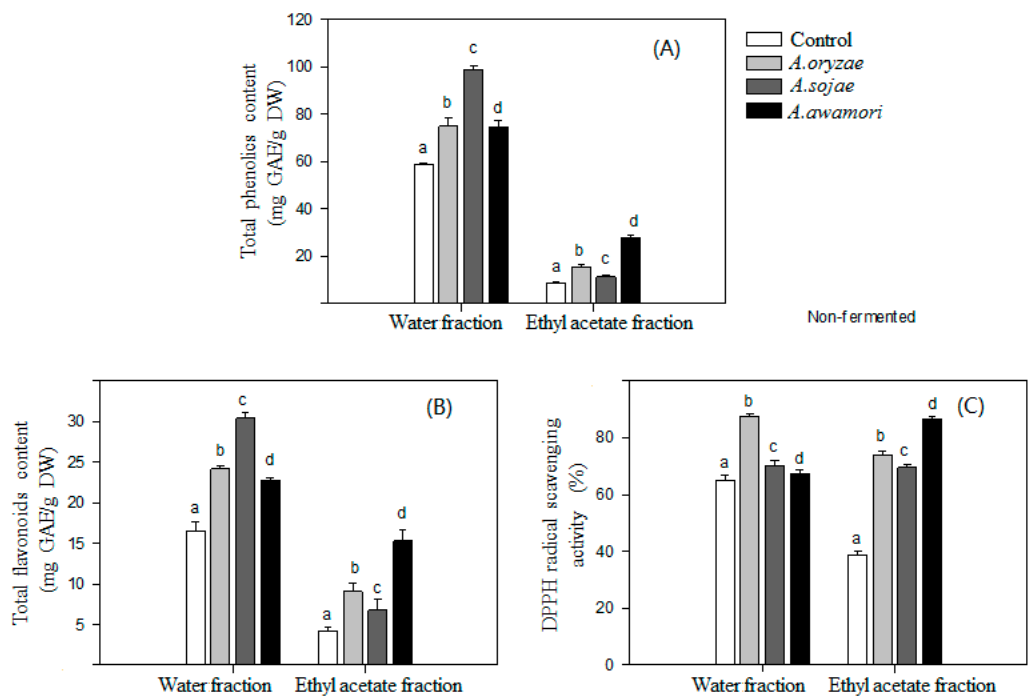
Figure 1. Changes of the contents of total phenolics ( A ) and flavonoids ( B ) with Aspergillus treatment and their DPPH radical scavenging activities ( C ). Data marked with the same letter above columns were not significant difference at p < 0.05 (mean ± SD, n = 3).